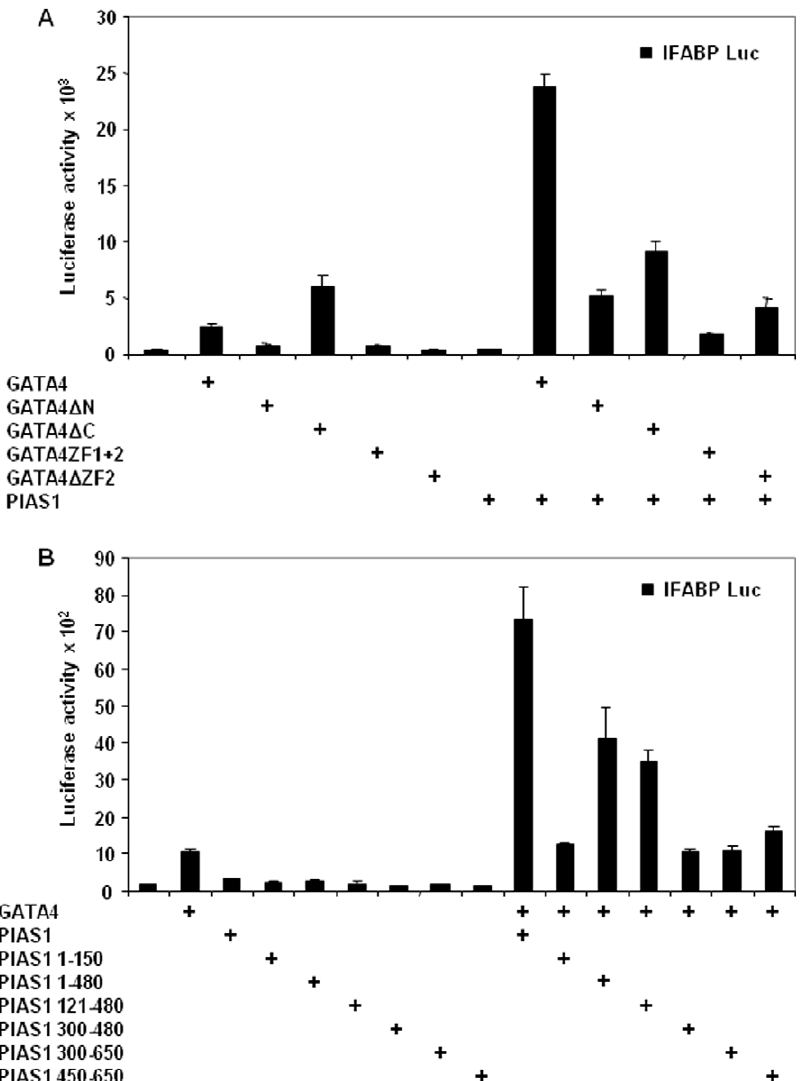
Figure 5. Mapping of GATA4 and PIAS1 domains required for IFABP coactivation. Transient cotransfections were performed in subconfluent HCT116 cells using wild-type and deletion mutants of GATA4 and wild-type PIAS1 ( panel A ). In panel B , wild-type and deletion mutants of PIAS1 and wild-type GATA4 were used for cotransfections. Lysates were assayed for luciferase activity 48 hours post-transfection. Results from 3 experiments done in triplicates are shown as mean 6